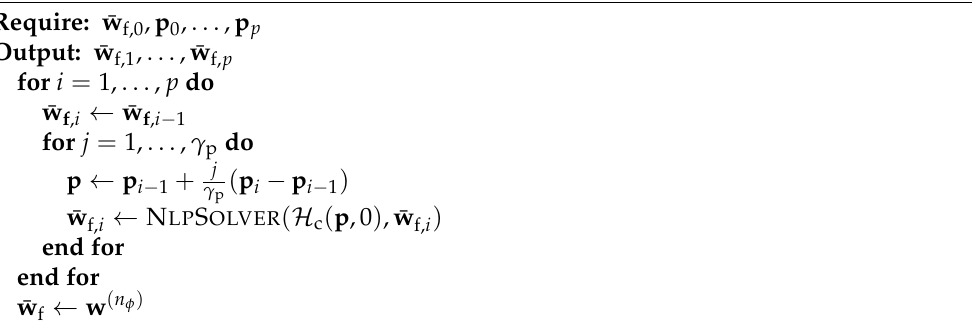
Algorithm 3 Parametric Sweep Interior-Point-based Homotopy (SIPH)